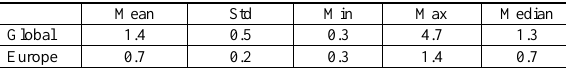
Table 1. Statistics of CODE model RMS values in 2018. Values